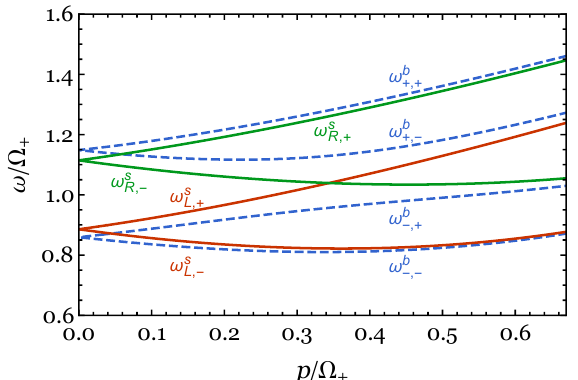
, ω s (green solid), R + R − , ω b , ω b , ω b (blue dotted). The definitions + , + + , − − , + − , −